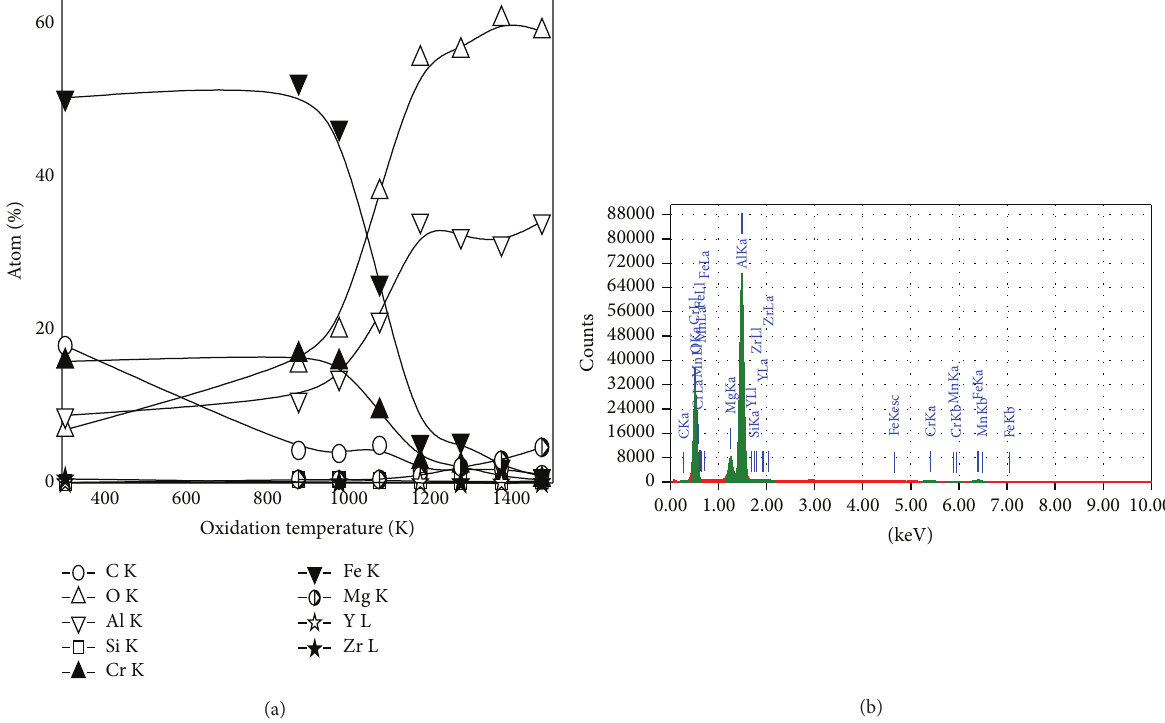
Figure 3: EDX analysis samples of as-received PM2000 and oxidized PM2000 (a) and example of EDX spectra of oxidized PM2000 at 1473 K used for composition calculation (b) (see Table 1).